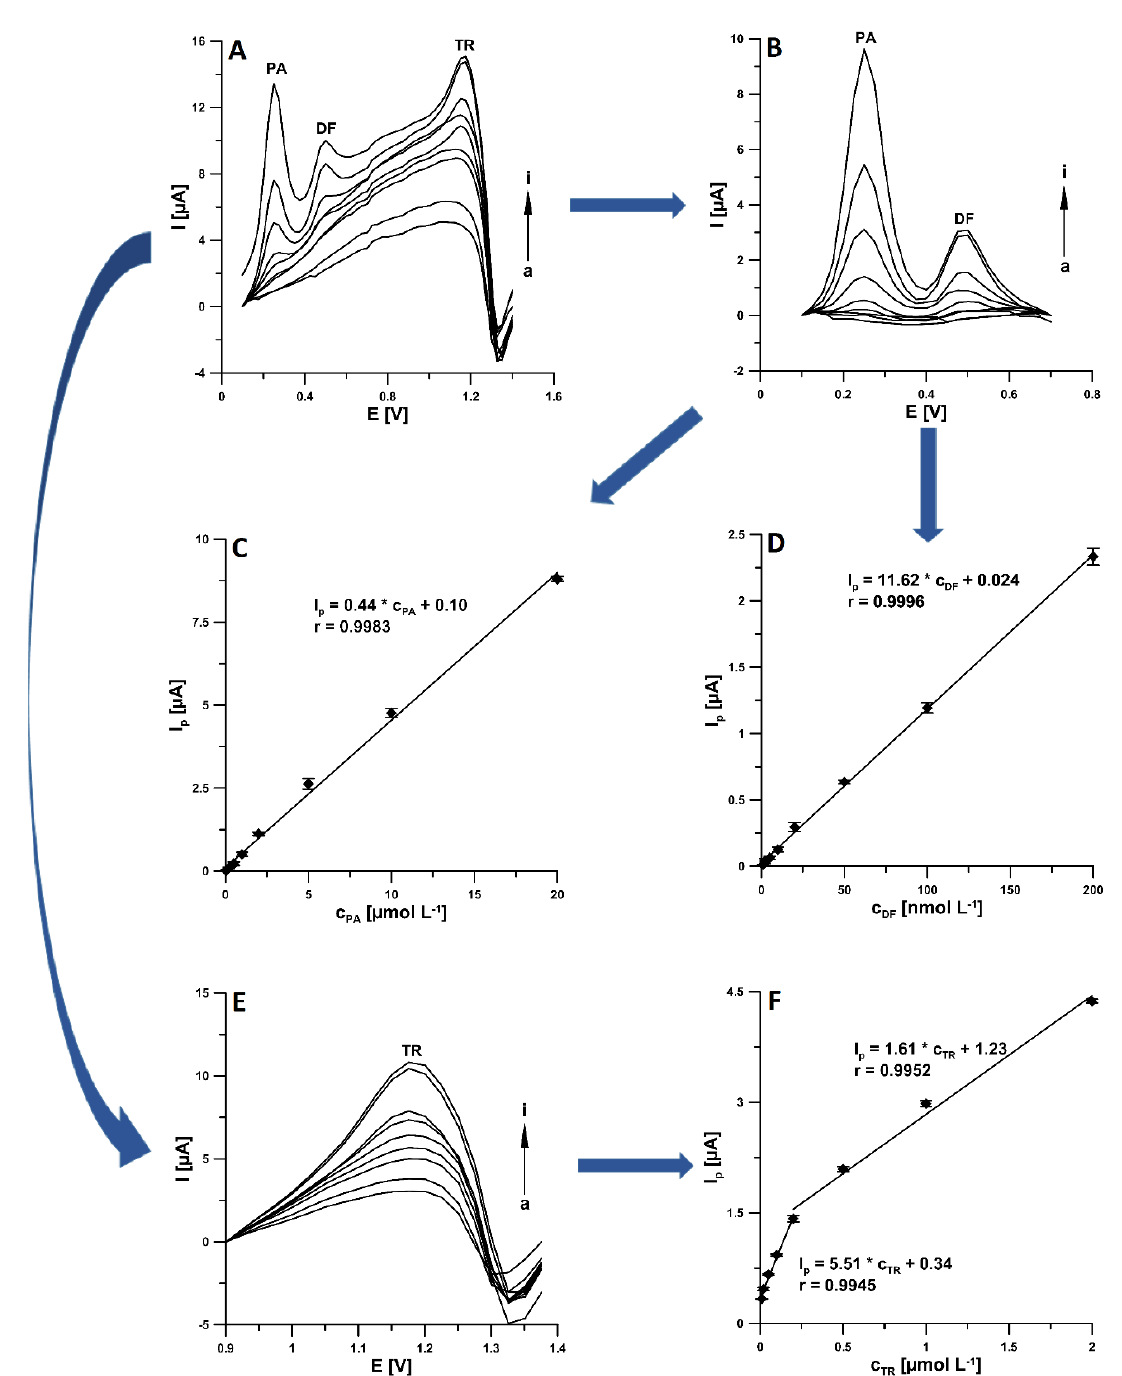
Figure 9. ( A ) Voltammograms obtained at the aSPCE/SDS in 0.075 mol L − 1 CH 3 COOH/CH 3 COONa buffer solution of pH 4.0 ± 0.1 containing increasing concentrations of PA (a–i, 0.05, 0.1, 0.2, 0.5, 1, 2, 5, 10, 20 µ mol L − 1 ), DF (a–i, 0.001, 0.002, 0.005, 0.01, 0.02, 0.05, 0.1, 0.2, 0.2 µ mol L − 1 ), TR (a–i, 0.01, 0.02, 0.05, 0.1, 0.2, 0.5, 1, 2, 2 µ mol L − 1 ). ( B ) Segment of voltammograms (A) in the potential range of 0.1–0.7 V. Linear range of the calibration curve of PA ( C ) and DF ( D , E ) Segment of voltammograms (A) in the potential range of 0.9–1.4 V. ( F ) Linear ranges of the calibration curve of TR. The DPAdSV parameters: E acc. of − 0.4 V, t acc. of 120 s, ∆ E A of 50 mV, t m of 10 ms, and ν of 250 mV s − 1 .